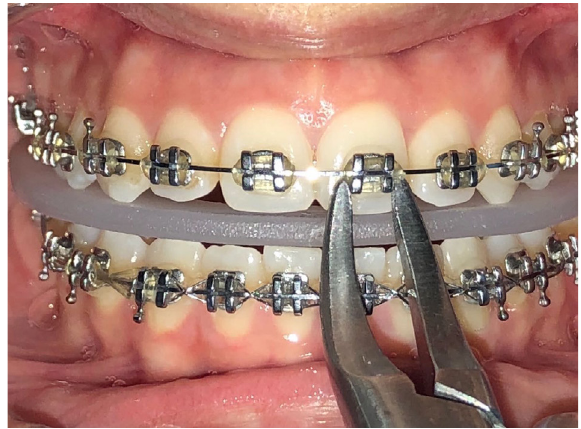
Figure 3- Intraoral photograph of debonding with soft acrylic bite